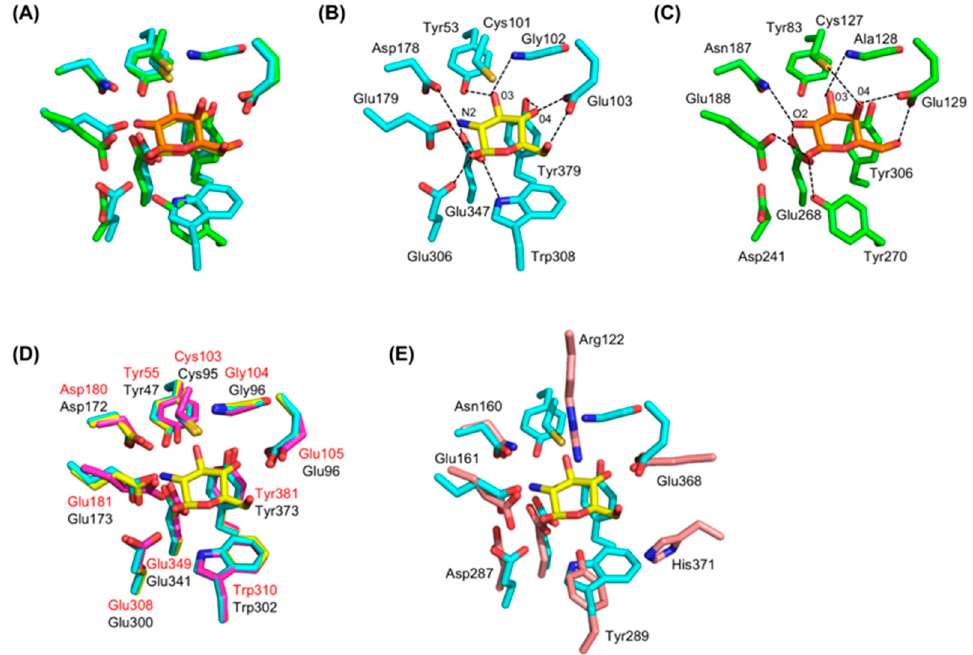
Figure 4. Comparison of the active site residues of GlmA Tk with those of representative enzymes of the families GH35, GH42, and other GlmAs. ( A ) Superposition of GlmA Tk (cyan sticks) and Hs- β -gal (green sticks) in complex with GlcN (yellow sticks) and galactose (orange sticks), respectively. Active site residues of GlmA Tk ( B ) and Hs- β -gal ( C ). Polar interactions are indicated by dashed lines; ( D ) Superposition of GlmA Tk (cyan sticks with red labels), GlmA Ph (magenta sticks with black labels), and GlmA Pf (yellow sticks); ( E ) Superposition of GlmA Tk (cyan sticks) and BbgII (GH42 β -galactosidase) (pink sticks with black labels). All the figures were drawn in the same orientation as in A.